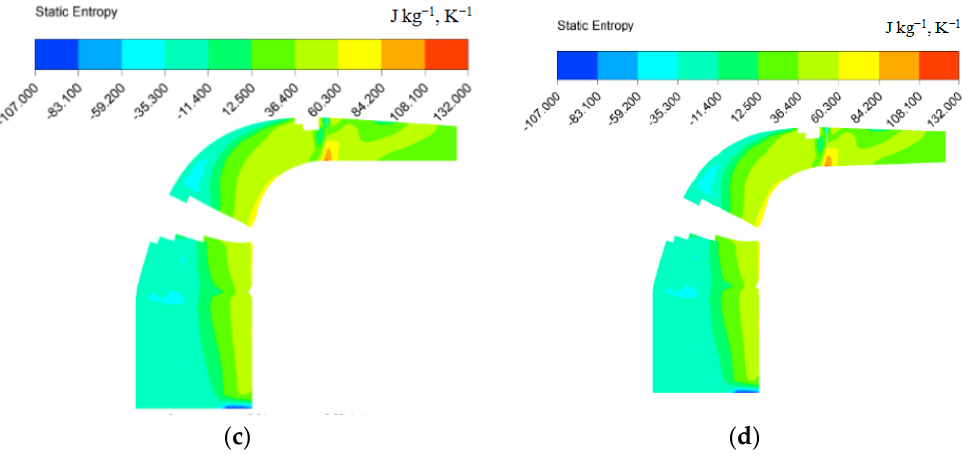
Figure 16. Meridional surface static entropy distribution at 0.6 relative mass flow: ( a ) parallel; ( b ) convergence from shroud; ( c ) convergence from hub; ( d ) equal convergence from shroud and hub.